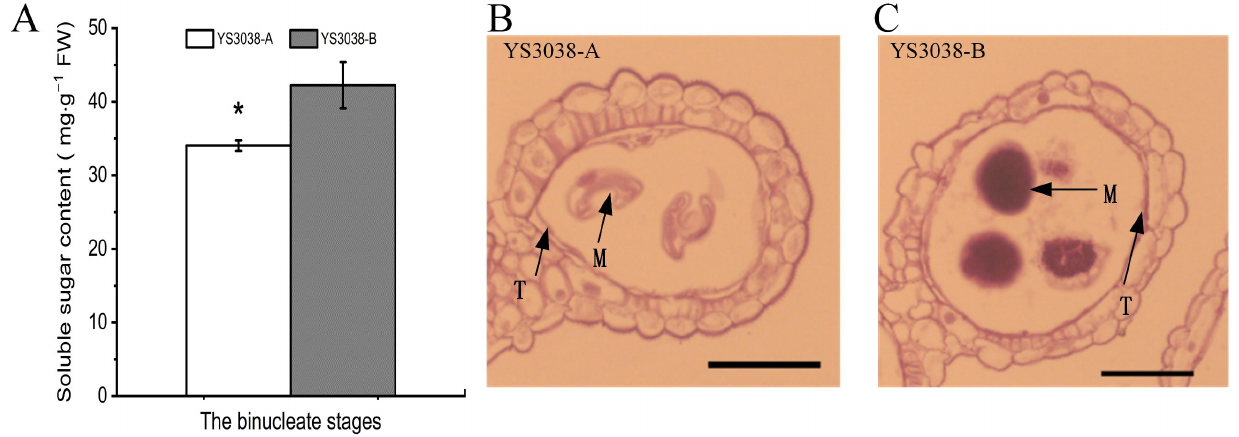
Figure 5. Sugar composition in YS3038-A and YS3038-B anthers. ( A ) Soluble sugar content. PAS staining of anther cross-sections in ( B ) YS3038-A plants compared with those of the ( C ) YS3038-B plants. T, tapetal layer; M, microspores; bars = 200 µ m. Significant differences were determined by Student’s t -test (* p < 0.05).